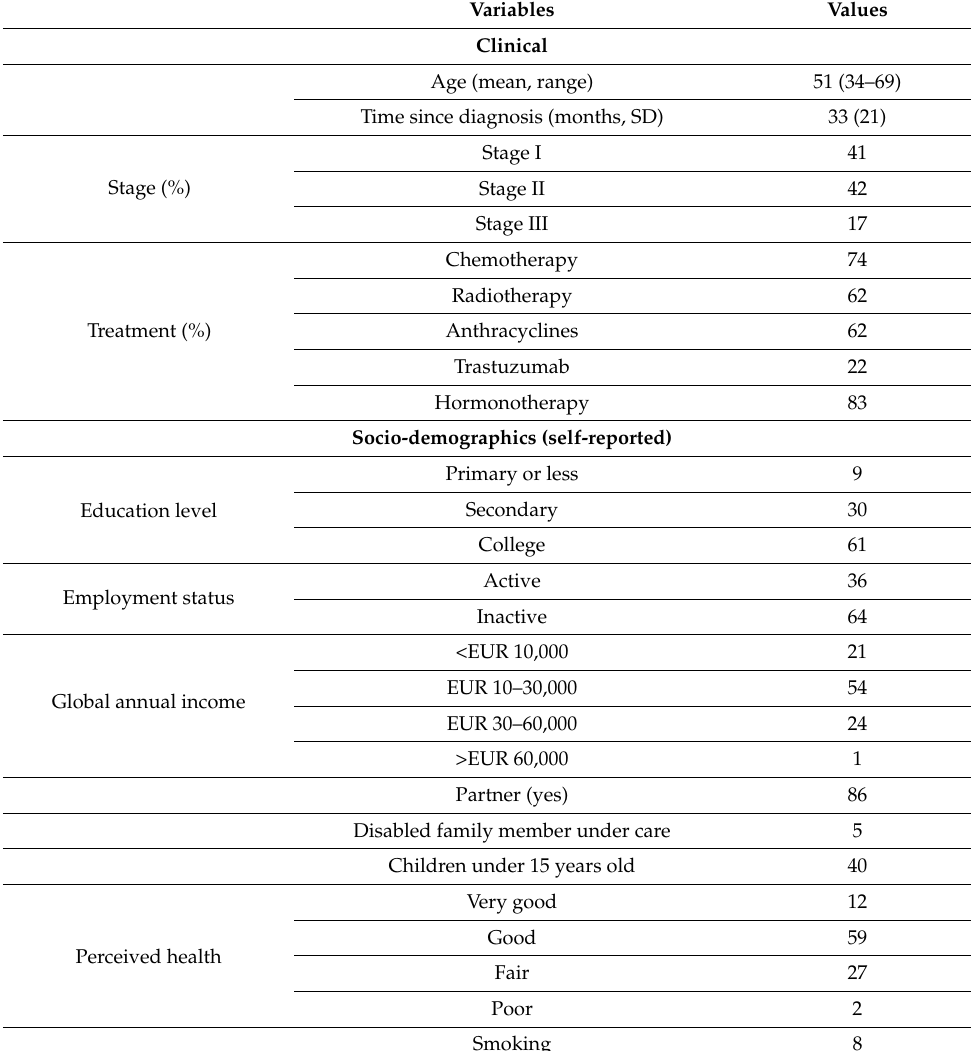
Table 2. Descriptive